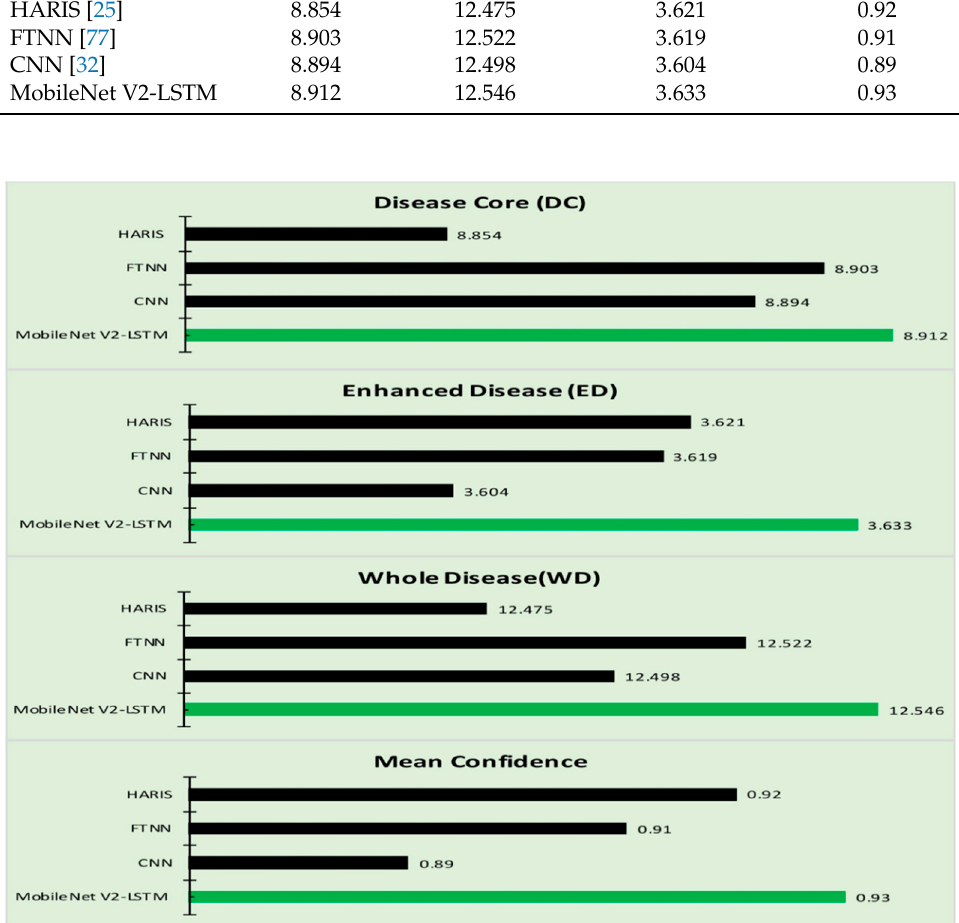
Figure 11. The progress of the disease growth.